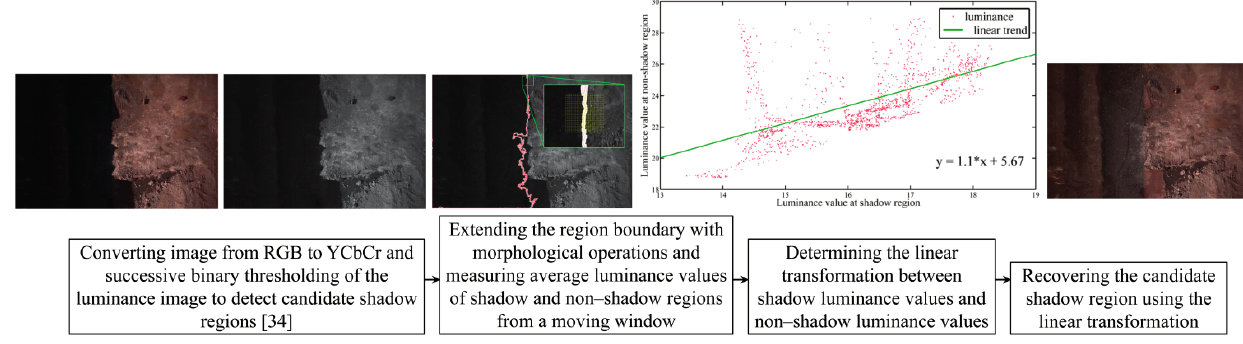
Figure 10. Workflow for automatic shadow detection and